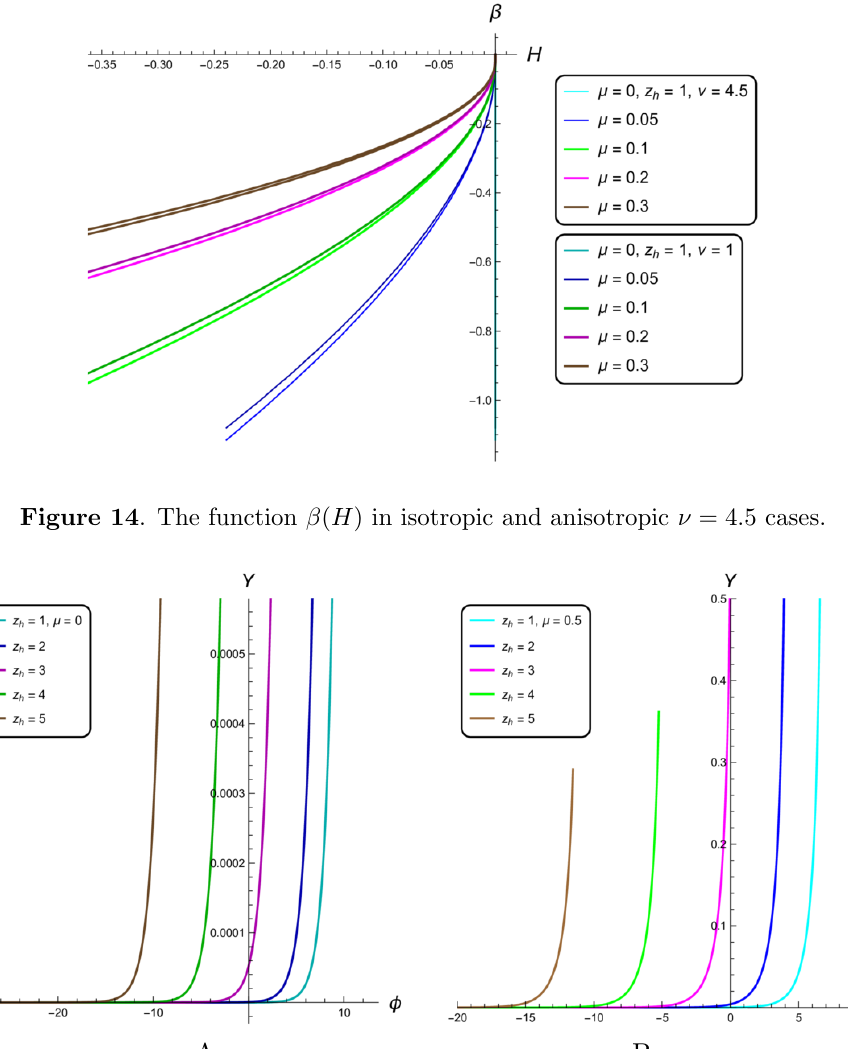
A B Figure 15 . Y (cid:13)ows in anisotropic case (cid:23) = 4 : 5 for di(cid:11)erent z h , (cid:22) = 0 (A) and (cid:22) = 0 : 5